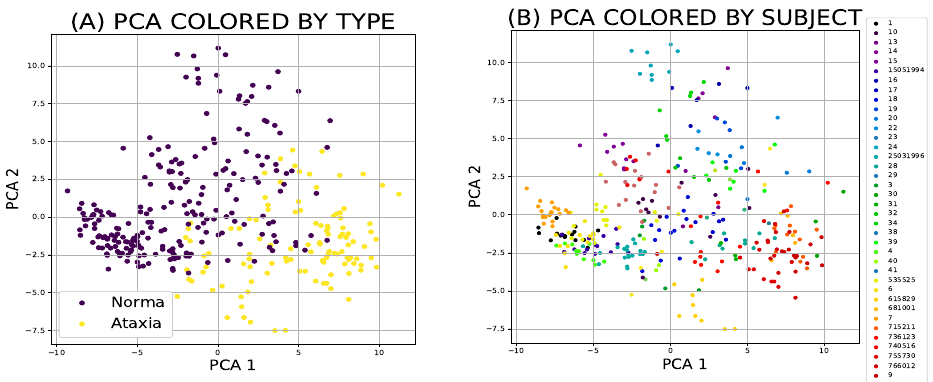
Figure 2. Principal component analysis is a tool that ranks the features by the eigenvalues, which corresponds to the desired ability of discrimination between classes ( A ). Of all the techniques compared, it has the worst ability to categorise individual participants ( B ).